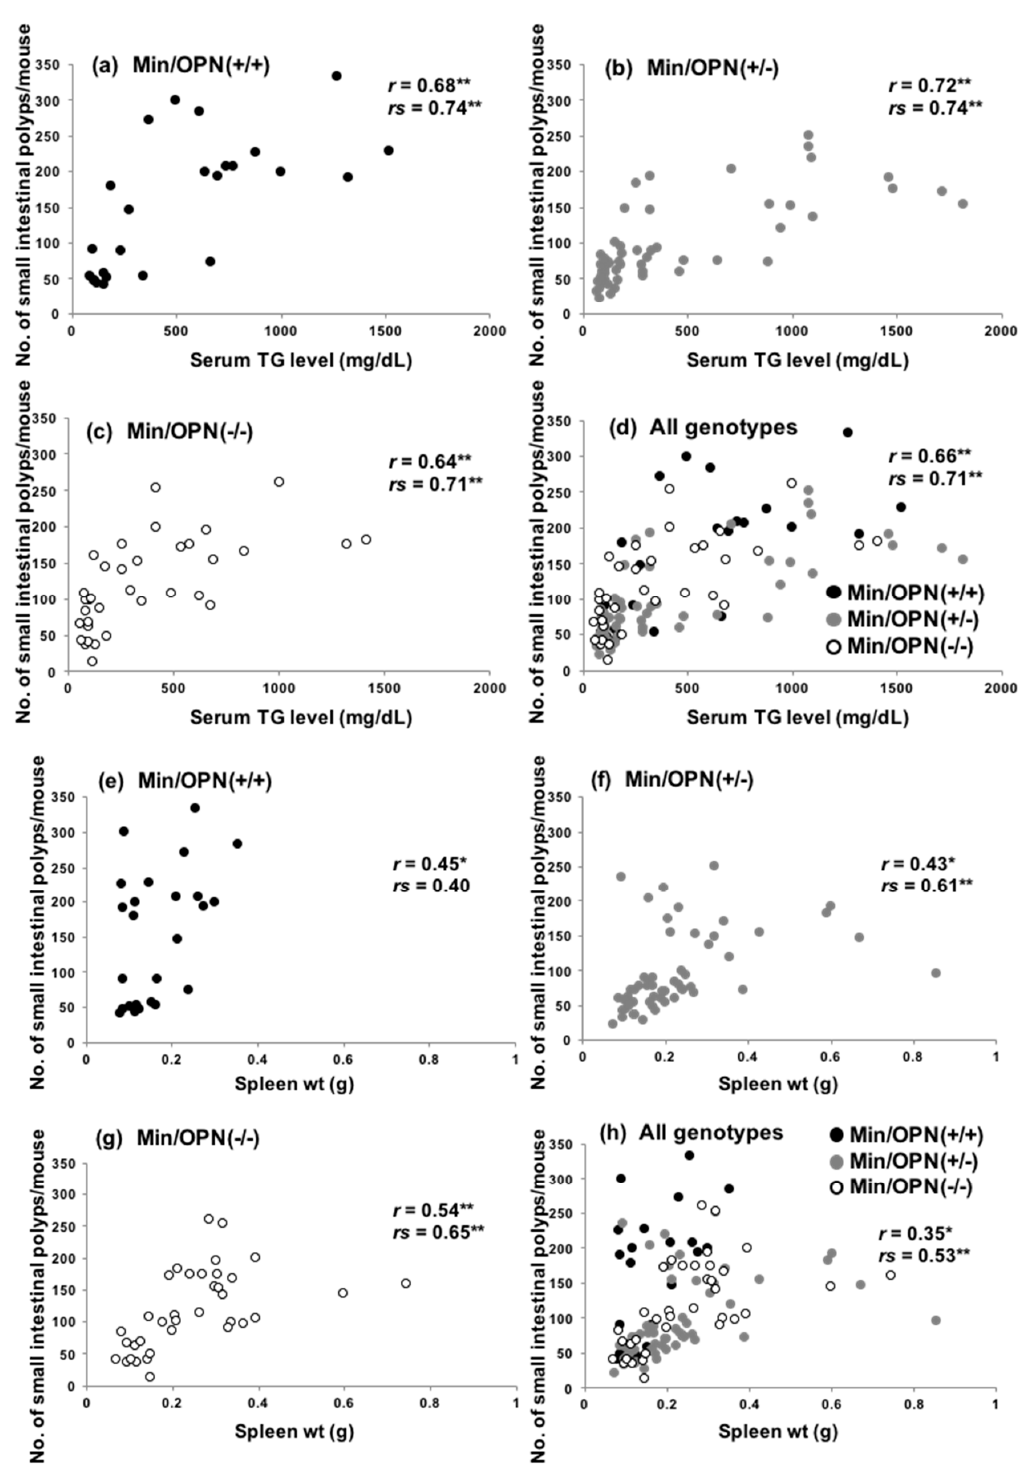
Figure 3. Scatter plots of serum triglyceride (TG) levels and intestinal polyp number in ( a ) Min/OPN(+/+), ( b ) Min/OPN(+/ − ), and ( c ) Min/OPN( − / − ) mice, and ( d ) all genotypes. Scatter plots of spleen weight and intestinal polyp number in ( e ) Min/OPN(+/+), ( f ) Min/OPN(+/ − ), and ( g ) Min/OPN( − / − ) mice, and ( h ) all genotypes. r , the Pearson correlation coefficient; rs , Spearman’s rank correlation coefficient; *, **, the correlation was statistically significant at p < 0.005, and p < 0.0005, respectively.